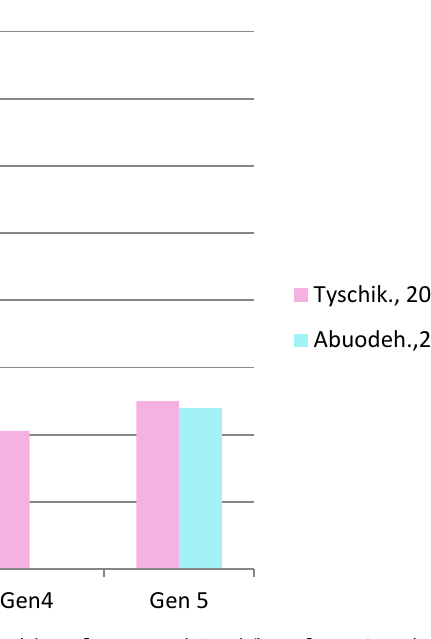
Figure 5 : The bar chart of the data which retrieved from Abuodeh et al., 2015 and Tyschik et al., 2018